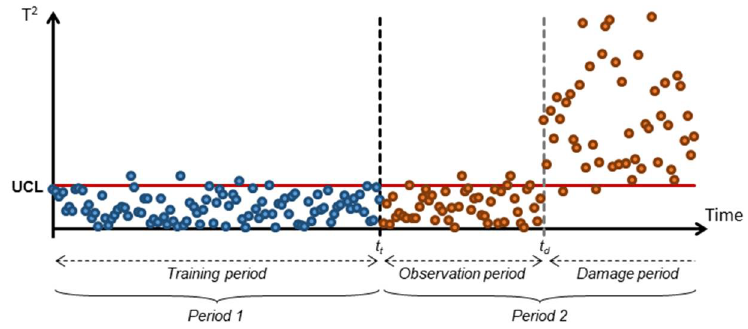
Figure 8. Procedure implemented to identify abnormal deviations of the natural frequency